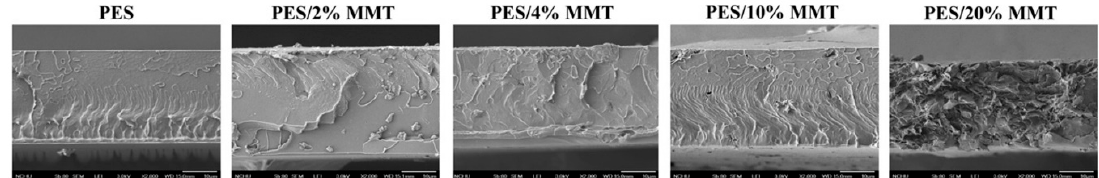
Figure 15. SEM photos for pure PES membrane and MMMs with different content of MMT.